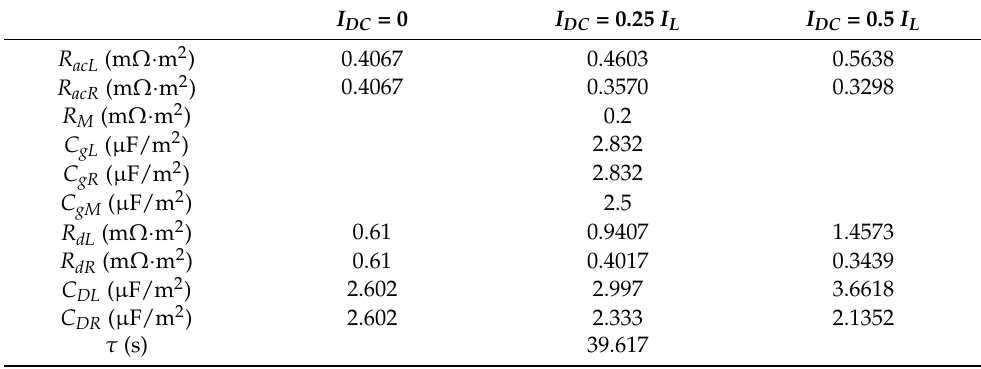
Table 1. Parameters of the electric circuit shown in Figure 2.